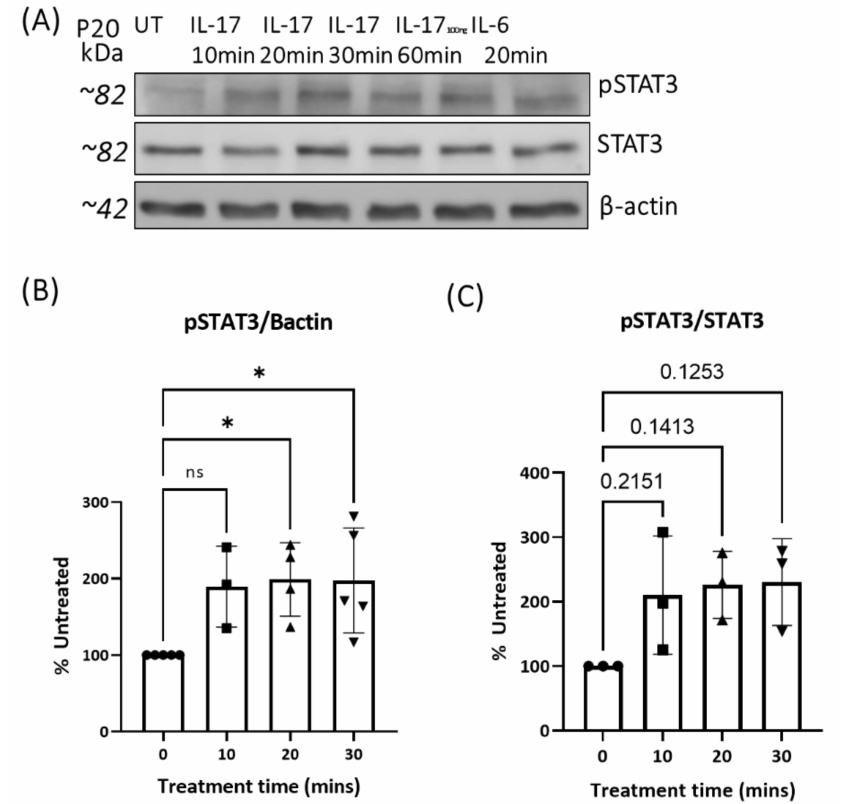
Figure A4. pSTAT3 expression in ARPE-19 cells after IL-17A treatment. ( A ) Representative Western blot images of n = 4 independent experiments. Densitometry of ( B ) pSTAT3/ β -Actin and ( C ) pSTAT3/STAT3. Mean ± SD; n = 4; * p < 0.05 by One-Way ANOVA with Dunnett’s post hoc tests, ns: no statistical